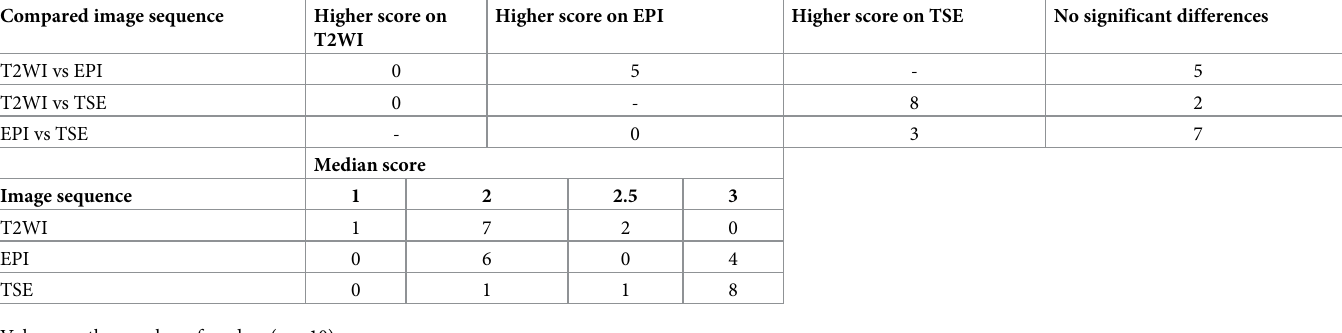
EPI 0 6 0 4 TSE 0 1 1 8 Values are the number of readers (n =